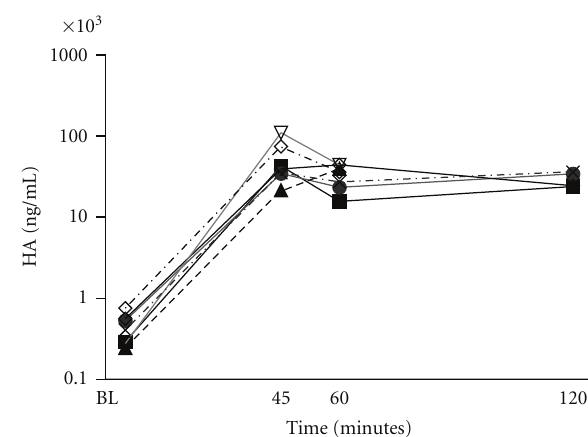
Figure 3: E ff ect of enzymatic degradation of the glycocalyx on functional capillary density (FCD). Data shown as values relative to baseline. Significant changes were found, between the enzyme group (E30) and control group (C30) after 60 minutes (E60, C60). After 120 minutes (E120, C120) there was a non significant trend ( P = 0 . 07).